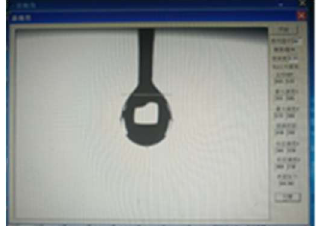
Figure 5. Contact angle of Hongqian crude oil on the surface of three materials From left to right, flexible composite pipe, plastic alloy pipe and 20# steel plate.